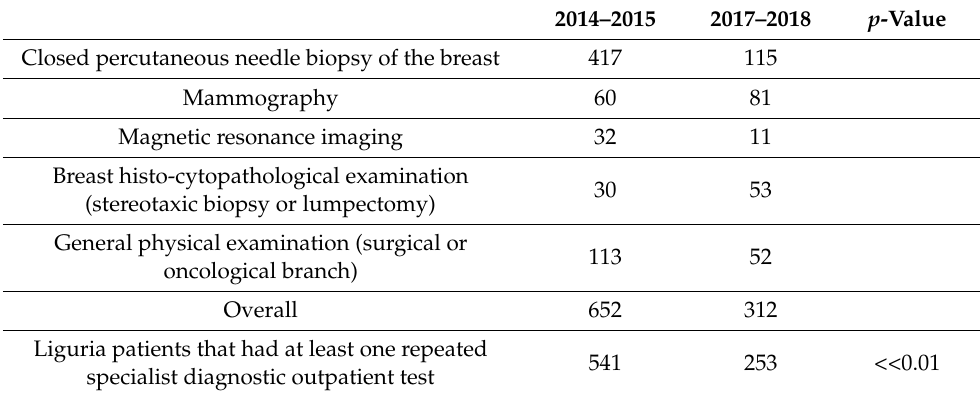
Table 3. Repeated specialist outpatient diagnostic procedures and period (before (2014–2015)